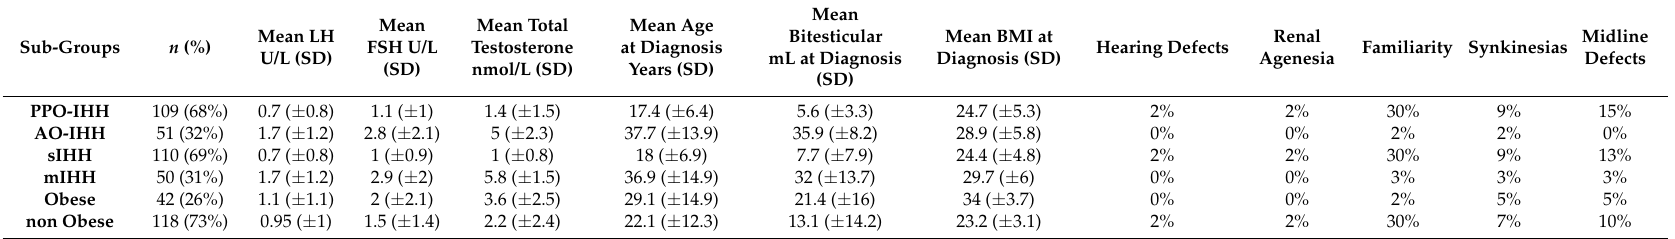
Table 1. Cohort clinical